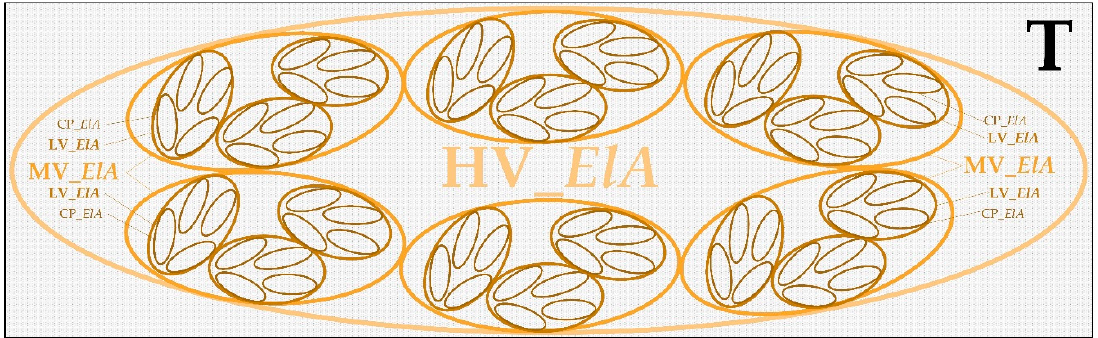
Figure 7. The fractal set of HV, MV and LVGs and customer plants (CP).